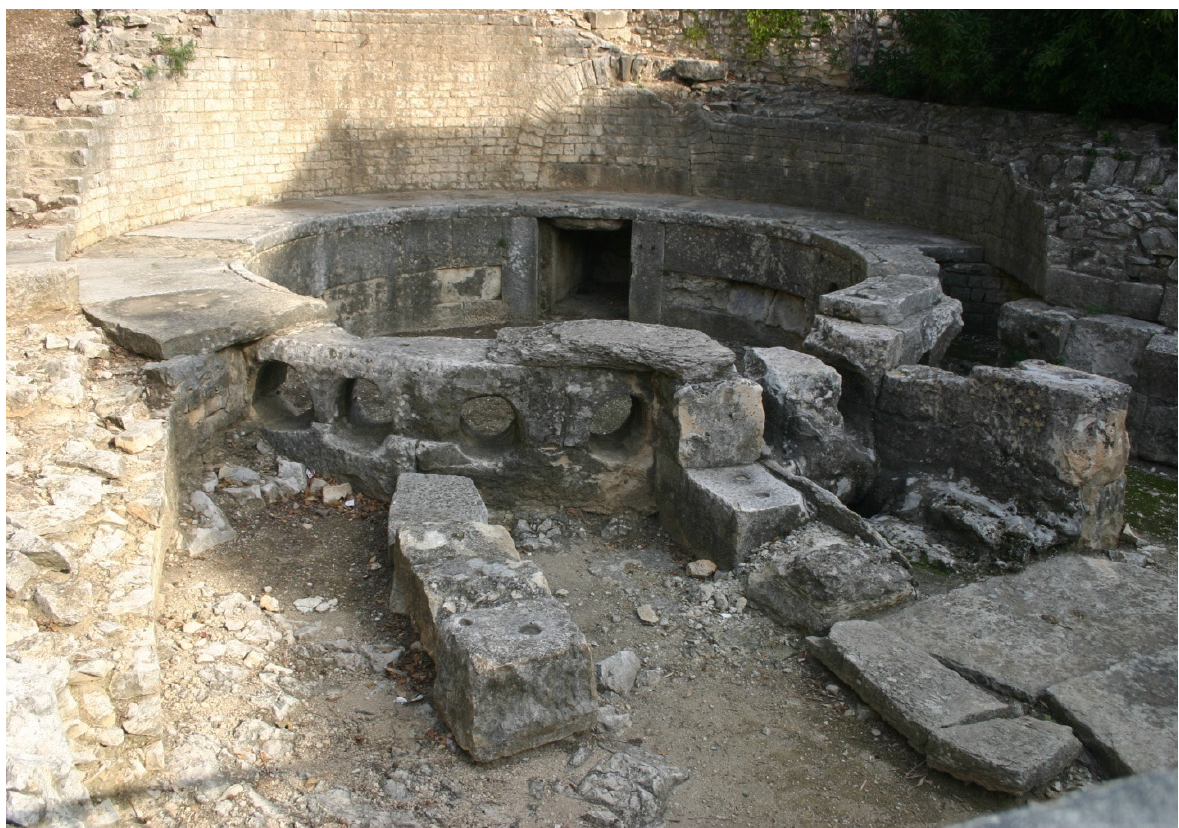
Figure 3. Front view of the Nîmes castellum .